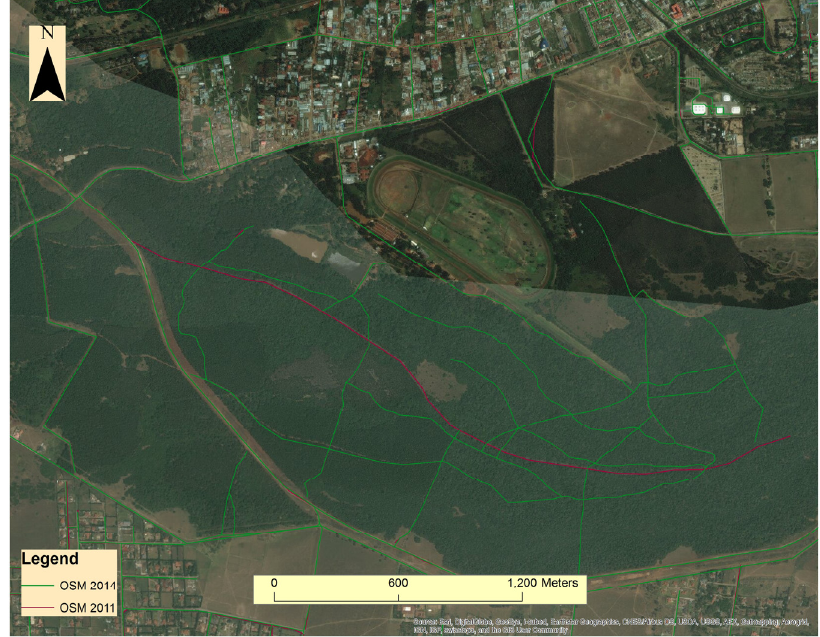
Figure 7. OSM roads in the Ngong Forest Reserve, Nairobi, Kenya (background imagery source: ESRI [80]).